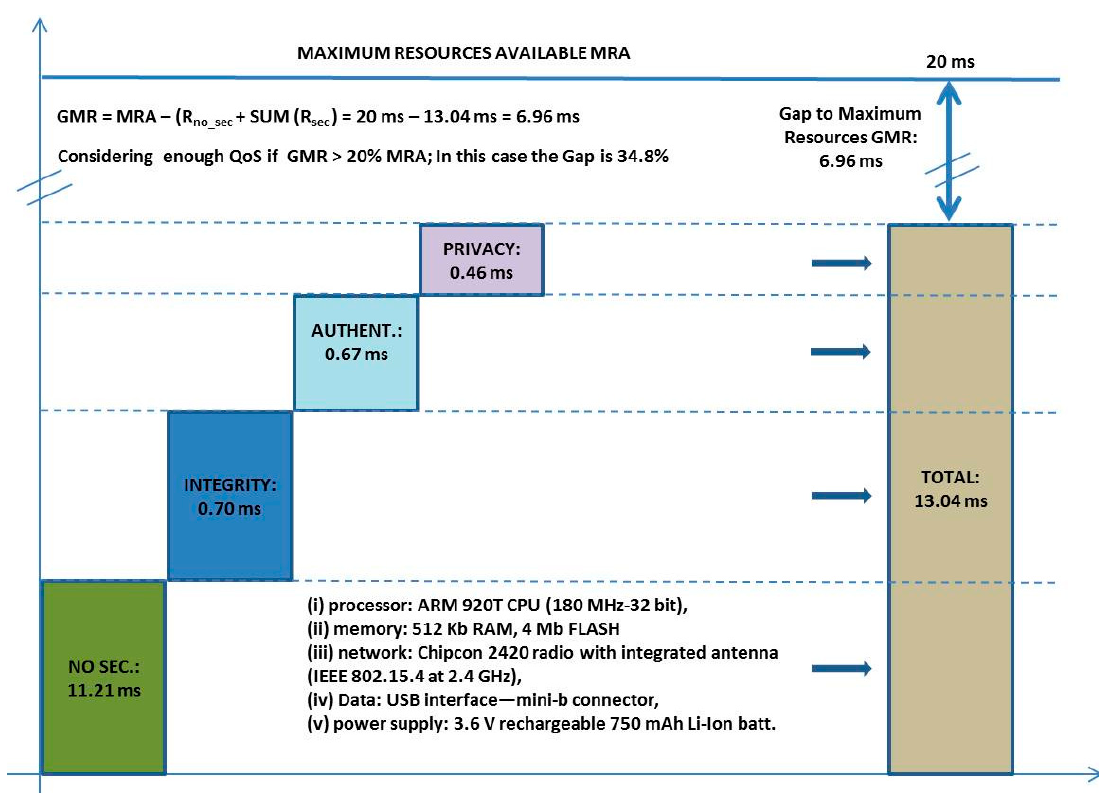
Figure 14. Delay vs. security services.